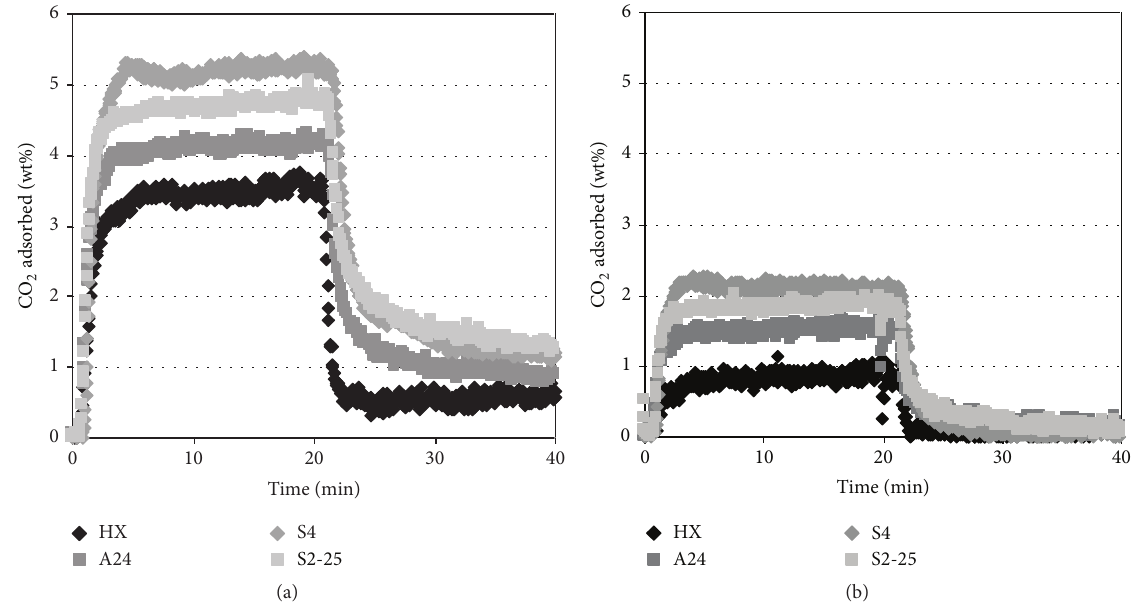
Figure 5: Typical mass flow records obtained for TGA of CO 2 sorption for selected materials (feed gas 90% CO 2 /Ar (0–20 mins), 100% Ar (20–40 mins)) at (a) 20 ∘ C and (b) 75 ∘